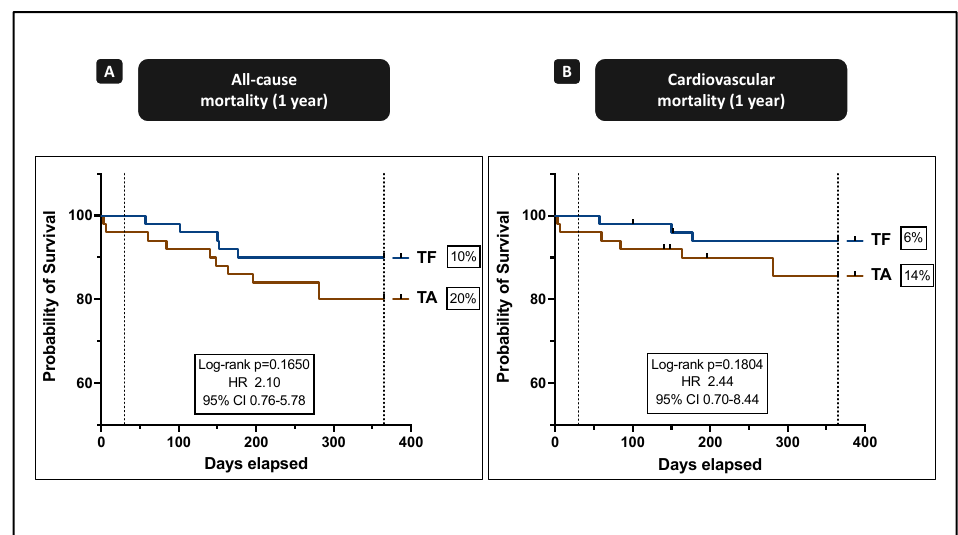
Figure 1. All-cause and cardiovascular mortality at one year. The percentage value on the right axis corresponds to the mortality rate. ( A ) All-cause mortality comparing TF and TA TAVR. ( B ) Cardiovascular mortality comparing TF and TA TAVR.